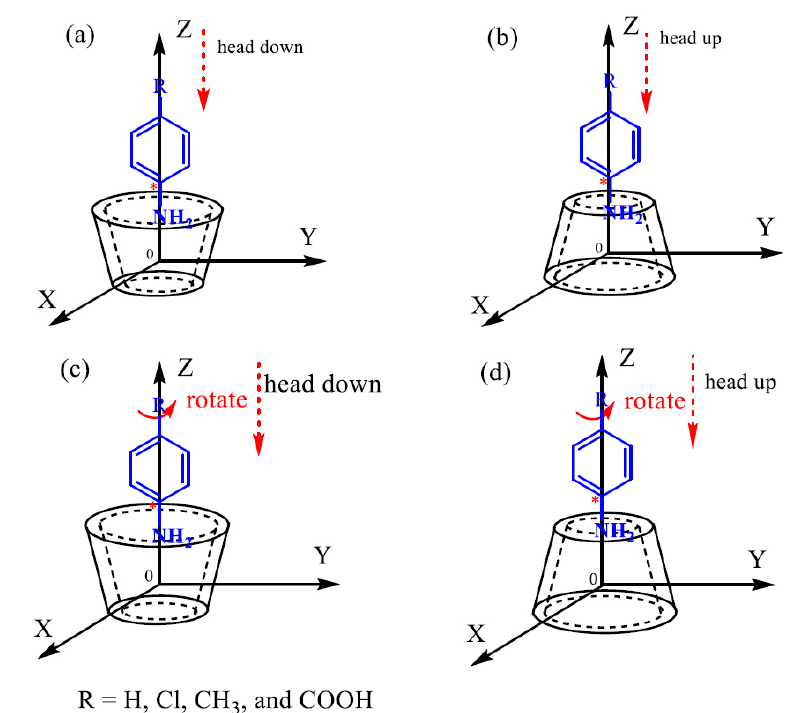
Figure 2. Inclusion processes of β -CD with guests: ( a ) head down, ( b ) head up of β -CD with anilines for steps; ( c ) head down, ( d ) head up of β -CD with anilines for dihedral angles.